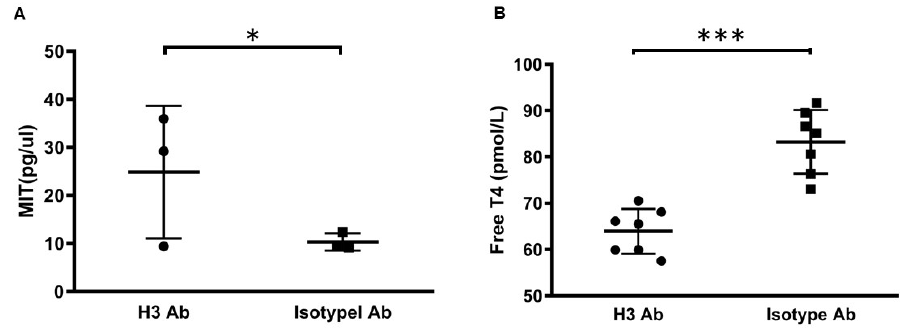
Figure 2. IYD blocking by H3 Ab. ( A ) H3 Ab or isotype control antibody was injected (50 µg/mouse i.p. 2 times/week) into C57BL/6J mice. After 3 weeks, urine samples from mice were analyzed by HPLC LC/MS. Significant differences between H3 Ab-treated and control mice are indicated by * p < 0.05 (Student’s t -test). Values are the mean ± s.d. for n = 3 mice. ( B ) H3 Ab or isotype control antibody was injected (50 µg/mouse, i.p. , 2 times/week) into C57BL/6J mice. After 3 weeks, blood serum was taken from mice and tested for free T4. Significant differences between H3 Ab-treated and control mice are indicated by *** p < 0.0005 (Student’s t -test). Values are the mean ± s.d. for n = 7 mice.